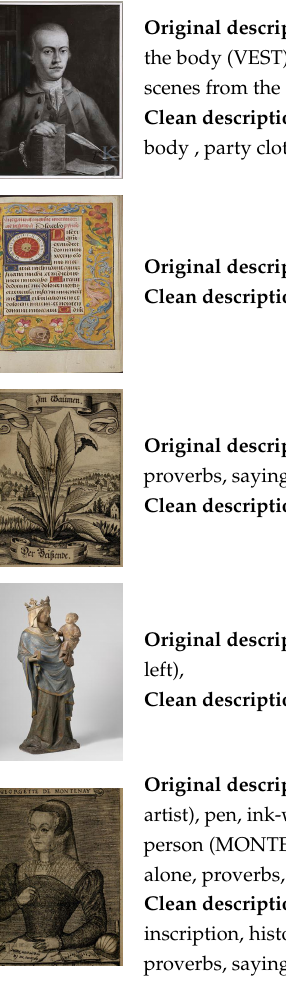
Figure 1. Example images from the Iconclass Caption dataset and their corresponding descriptions before and after preprocessing.